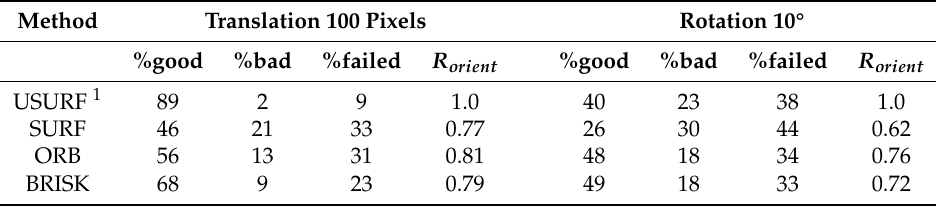
Table 7. Percentage of features matching successfully (good), those incorrectly matched (bad), and those that failed to match (failed) for the different descriptor methods, a 100 pixel translation, and a 10°rotation. Results shown here are for the flat lapping reaming ( R z = 1.6 µ m) surface finish.